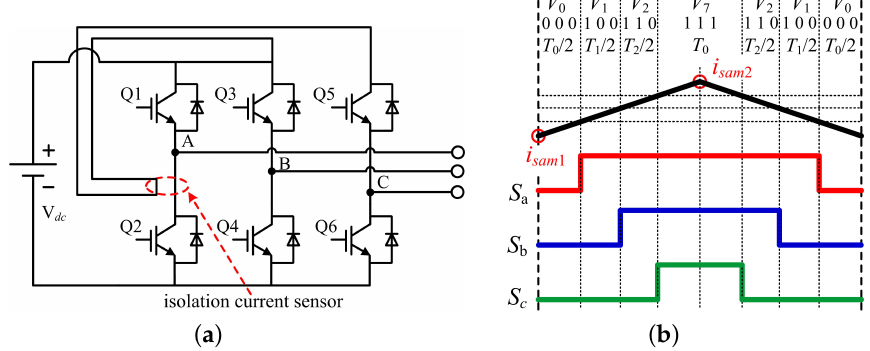
Figure 4. The circuit topology and sampling points of the novel phase current reconstruction approach. ( a ) the circuit topology and the installation position of the single hall-effect current sensor; and ( b ) two sampling points during a PWM